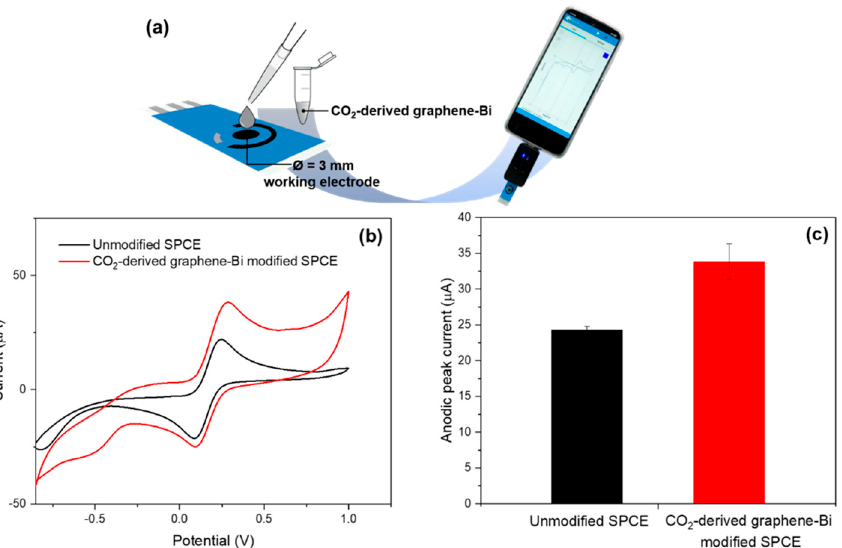
Figure 10. Illustration of CO 2 -derived graphene–Bi modified SPCE for electrochemical sensor application ( a ), cyclic voltammograms of 5.0 mM [Fe(CN) 6 ] 3 − /4 − in 0.5 M KCl using unmodified and CO 2 -derived graphene–Bi modified SPCE ( b ), and anodic peak current obtained from the cyclic voltammograms in ( b , c ). The error bars correspond to the standard deviation obtained from three measurements ( n = 3).